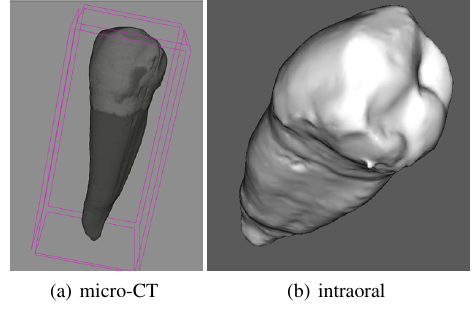
Figure 5. Micro-CT and intraoral scans of 4.4 premolar (Early